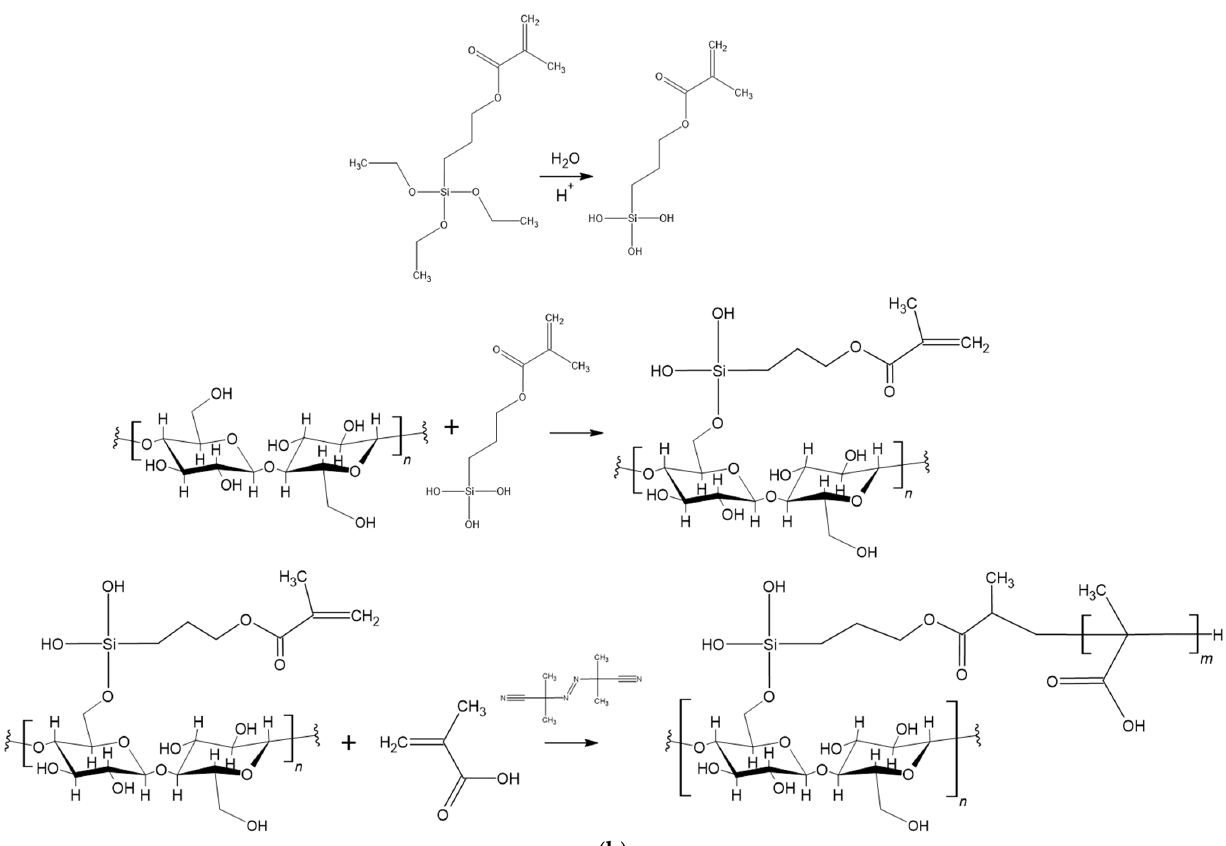
Figure 1. Reaction schemes for the chemical modification of microfibrillated cellulose for obtaining: ( a ) MC-SIV and MC-SIV-MA, ( b ) MC-SIMA and MC-SIMA-MA .